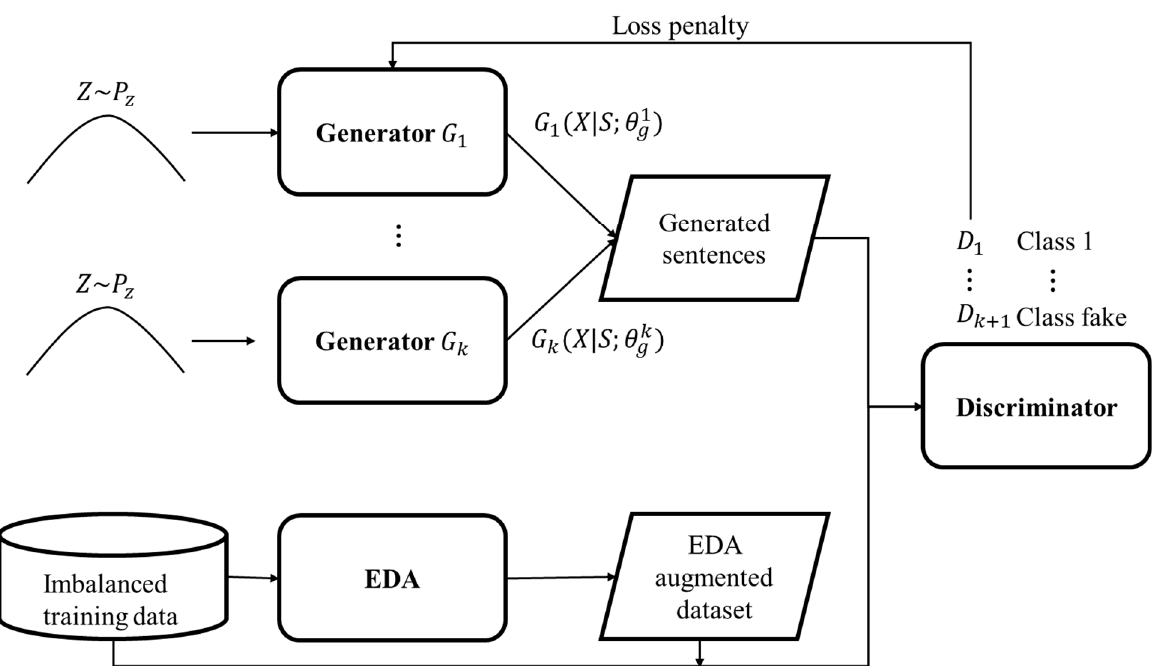
Figure 2. The model diagram of the HEGS training